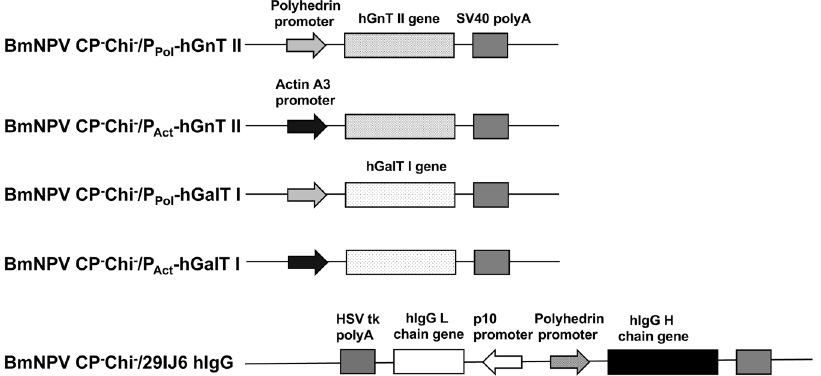
Figure 1. Expression cassettes in each recombinant BmNPV bacmid. Each recombinant BmNPV bacmid was constructed as described in the Materials and Methods section. Each BmNPV was prepared in silkworm larvae via the injection of each recombinant BmNPV bacmid into larvae.